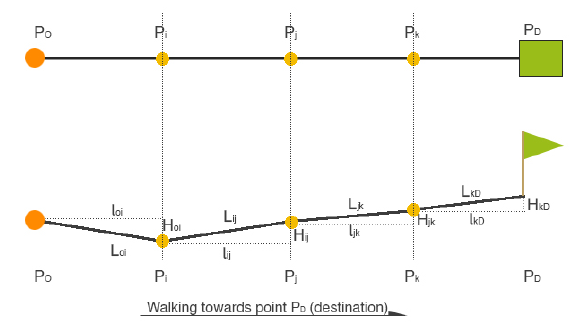
Figure 6. Travel distance calculated with travel time and speed impacted by the slope